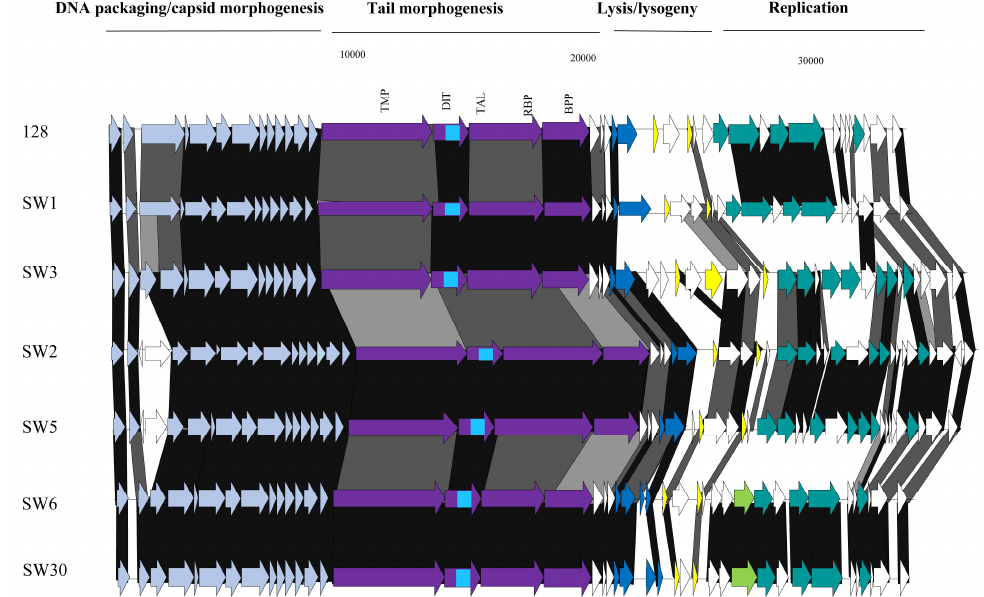
Figure 5. Genome comparisons of representative cos phages from this study and in comparison with phage 128 from a previous study [7]. The functions of the gene modules are indicated above the diagram and correspond to the colour-coded arrows as follows: pale blue arrows represent genes encoding DNA packaging and capsid morphogenesis functions; purple arrows indicate tail adhesion/injection device components including the TMP, Dit, Tal–RBP, and baseplate proteins (BPP); yellow arrows represent repressor/anti-repressor encoding genes; lime green arrows represent type III restriction endonuclease R subunit-encoding genes; and teal green coloured arrows represent genes encoding predicted DNA replication functions. The bright blue area within the arrow representing the Dit-encoding genes represents the region that encodes a carbohydrate binding domain. Where arrows are joined by a black shaded area, the represented gene products are between 90% and 100% similar at the aa level; dark grey indicates 70–89% similarity and light grey indicates 50–69% aa identity between the gene products. Unshaded regions represent those possessing less than 50% aa